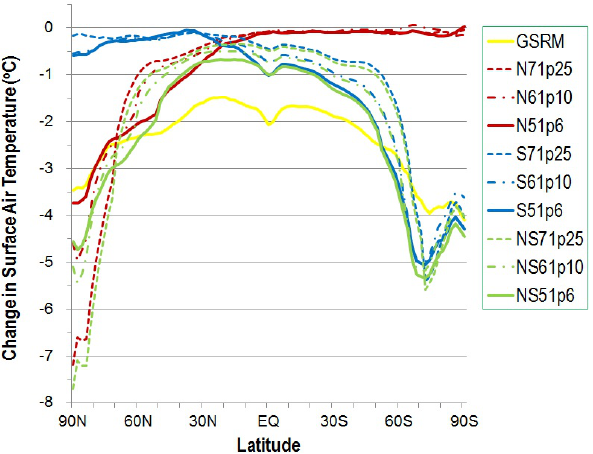
Fig. 3. Latitudinal variation of the change in temperature (in Kelvins) induced by the set of the ten global and polar solar reduc- tion simulations. The plot is linear in latitude to provide improved resolution in high latitudes; an equal area weighting would show that the simulations with polar reductions in solar radiation are more tightly restricted to polar regions and that the global reduction cools a much larger fraction of the Earth than the polar reductions.